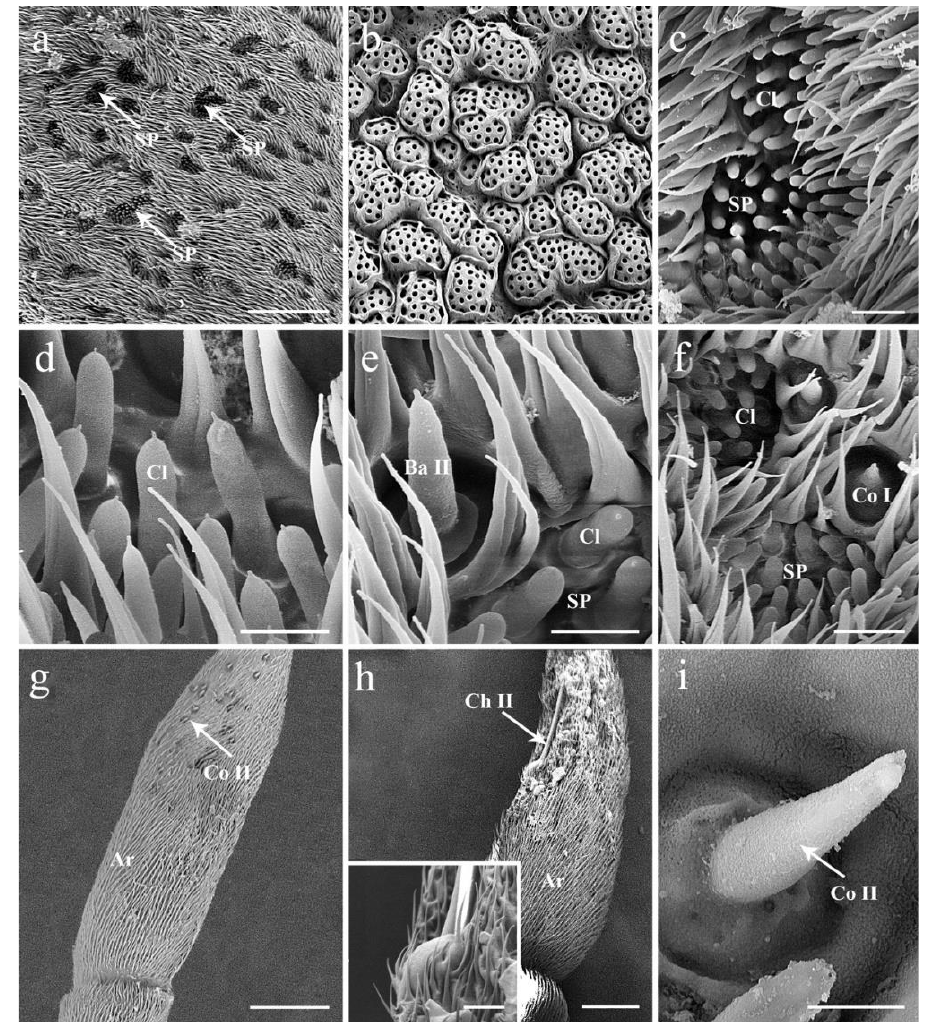
Figure 3. Scanning electron micrographs of sensory pits and the arista in female Gyrostigma rhinocerontis . ( a ) A large amount of sensory pits on postpedicel surface. ( b ) Interior surface of sensory pits, showing fusion between adjacent pits. ( c ) Dorsal view of ‘super sensory pit’. ( d ) Clavate sensilla clustered in a sensory pit. ( e ) Sensory pit accompanied by single basiconic sensillum. ( f ) Sensory pit accompanied by single coeloconic sensillum. ( g ) Coeloconic sensilla II on basal part of second segment of arista. ( h ) Chaetic sensillum II on basal part of arista, with swelling at base (insert). ( i ) Magnification of coeloconic sensilla II in G. rhinocerontis Scale bars: ( a , g ) = 100 μm, ( b ) = 50 μm, ( c , f ) = 10 μm, ( d , e ) = 5 μm, ( h ) = 50 μm, 10 μm in inset, ( i ) = 3μm. Abbreviations: Ar, arista; Ba II, basiconic sensillum II; Co I, coeloconic sensillum I; Co II, coeloconic sensillum II; Cl, clavate sensillum; Ch II, Chaetic sensillum II; SP, sensory pit.